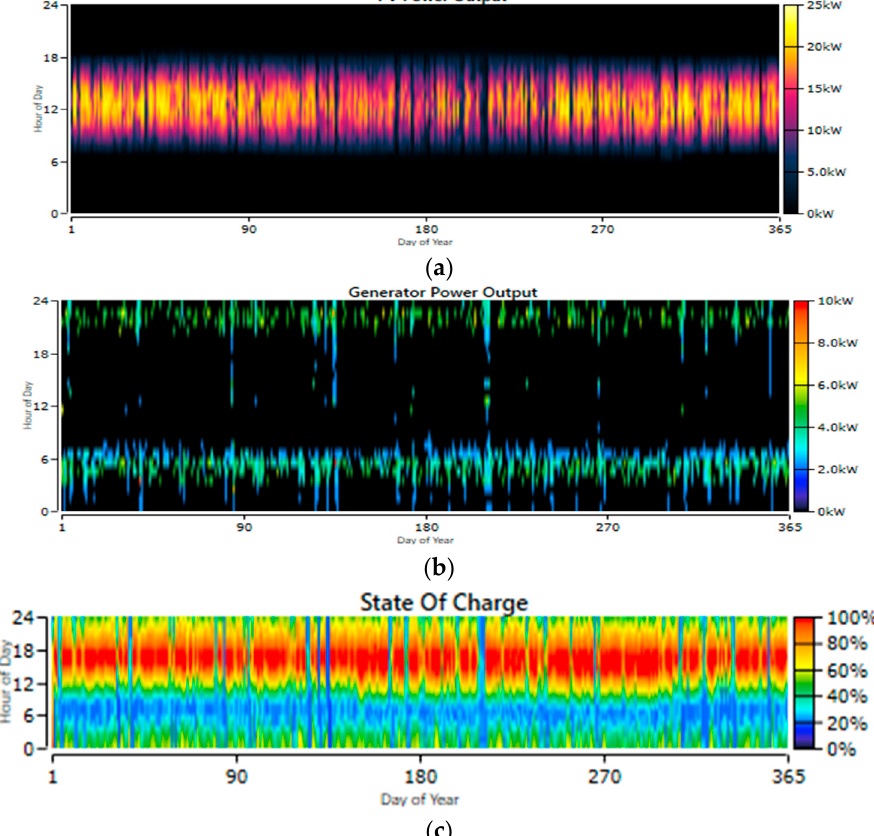
Figure 14. Yearly power delivering status. ( a ) PV system, ( b ) diesel generator, ( c ) battery.